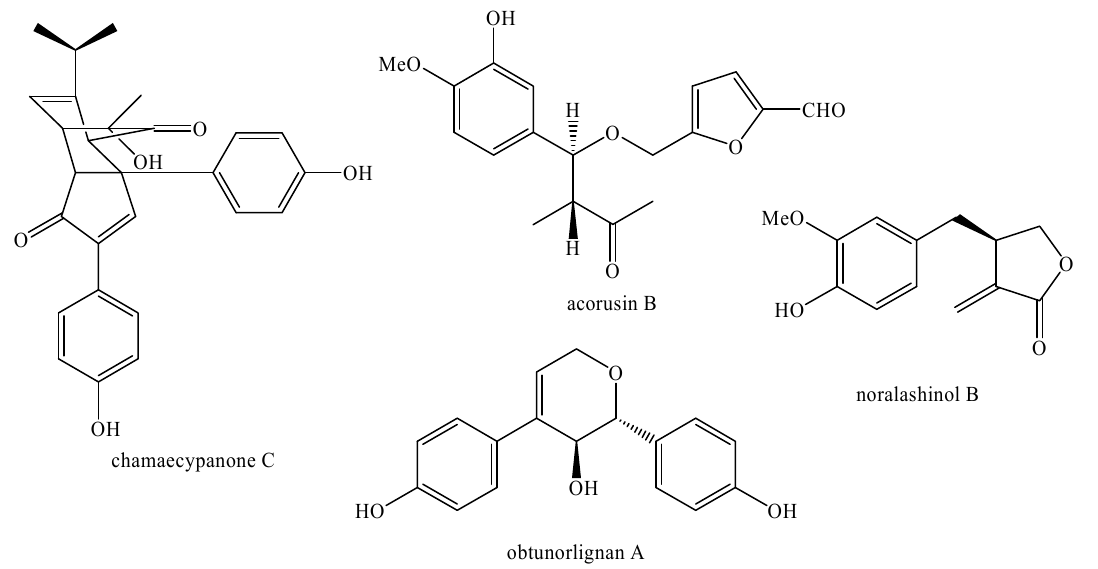
Figure 15. Isolated nor -lignans in the plant kingdom—part 14.